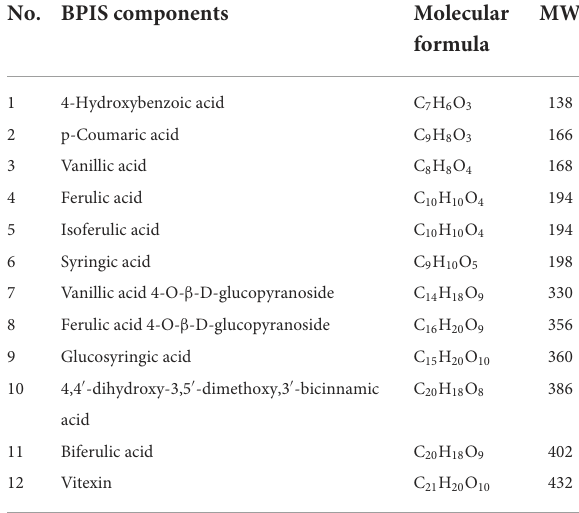
TABLE 2 Twelve phenolic acids in bound polyphenol of the inner shell (BPIS) extracted from millet bran (MW, molecular weight). No. BPIS